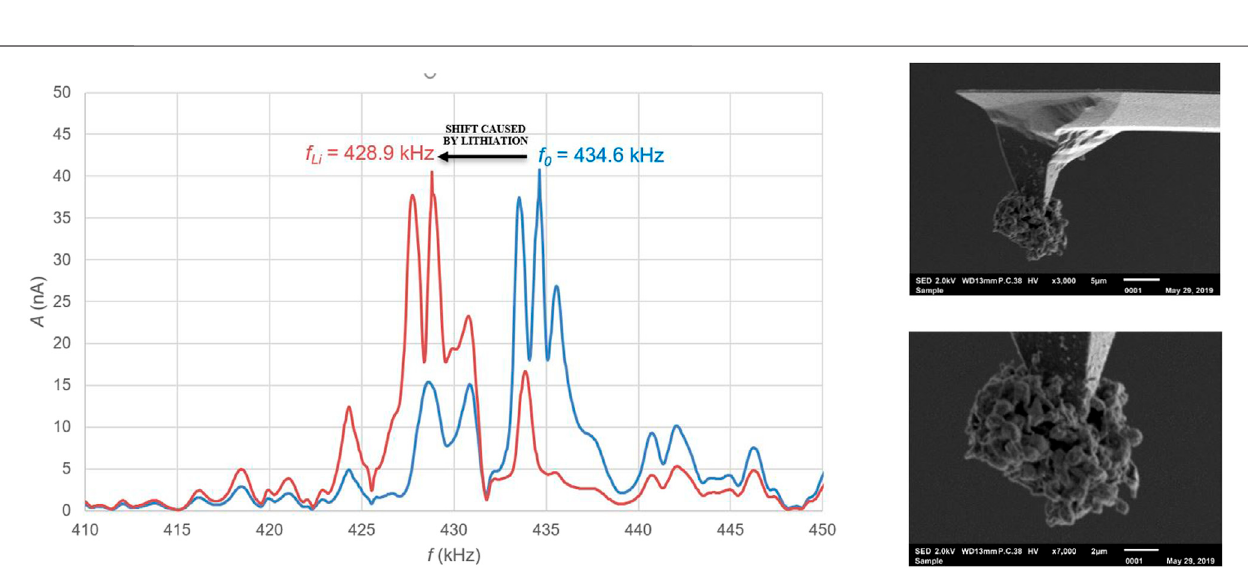
FIGURE6| Left:Absoluteshiftofresonancefrequencyasaresultoflithiationofthetipbyelectro-chemicalplating.Right:Asphereoflithiumdendritesattheendof the tip applied by electrochemical plating.